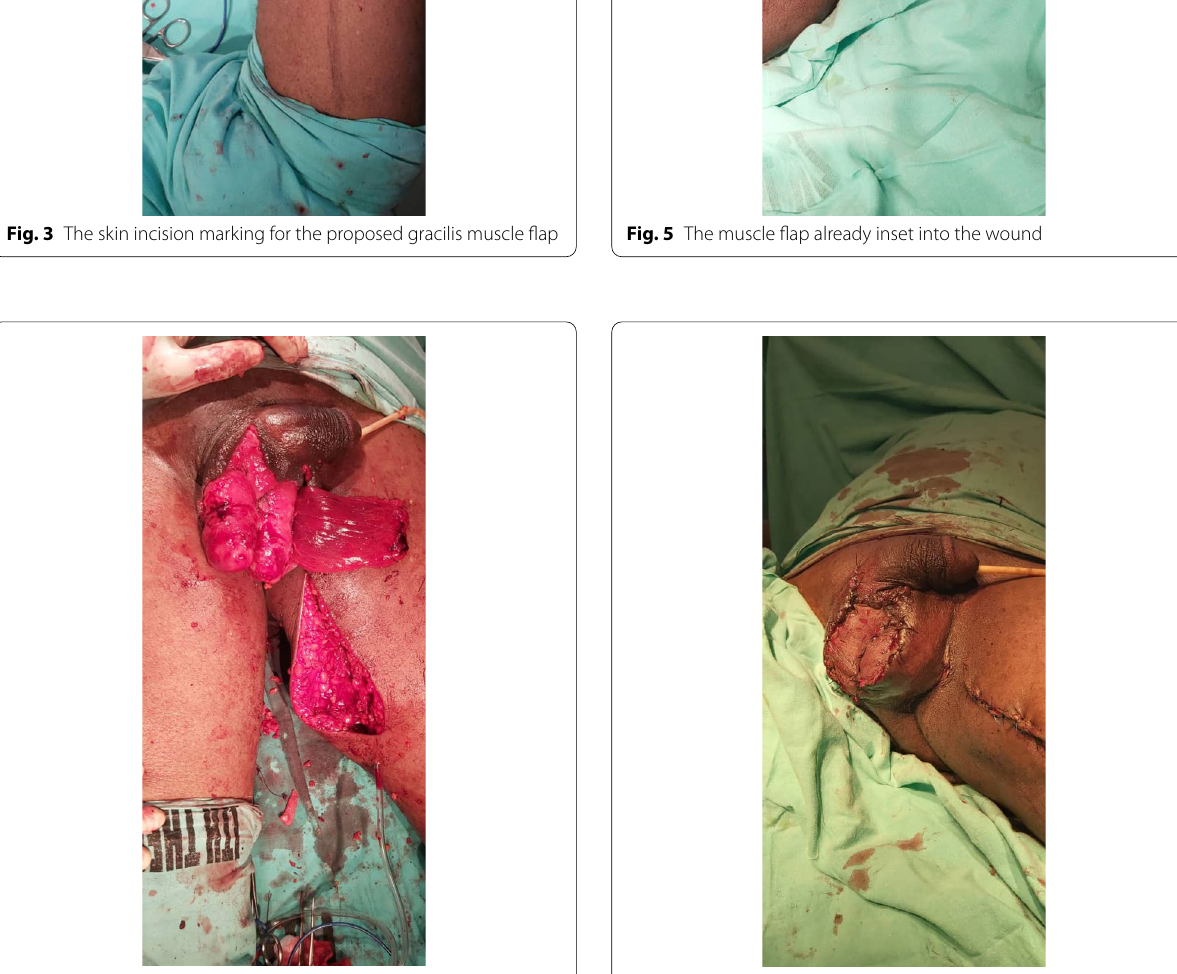
Fig. 4 The muscle flap before insetting